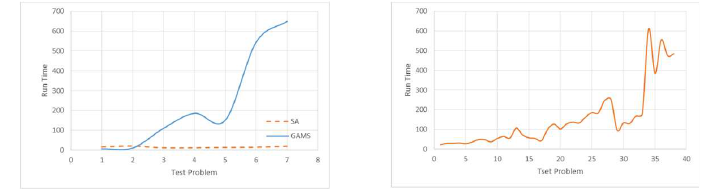
Fig. 9. Run time for P 8 to P 45 (SA)